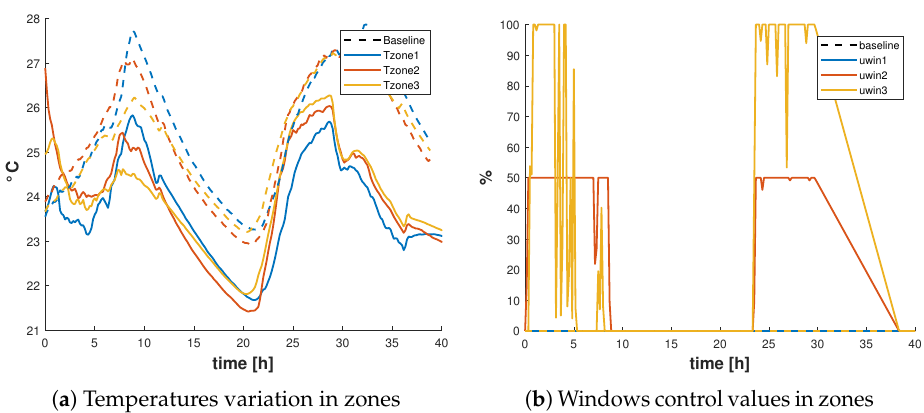
Figure 4. Comparison between DiMPC (plain lines) and baseline (dash line) control algorithms during summer: DiMPC is enabled during 40